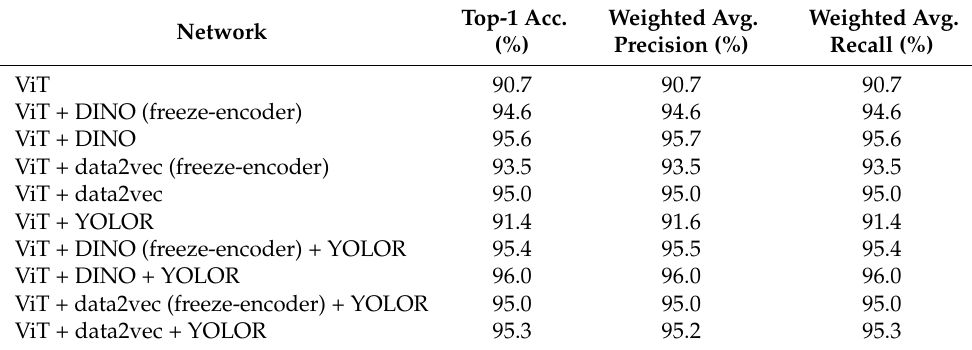
Table 4. Comparison of the supervised ViT model and the composite models under different training schemes. Top-1 Acc. Network